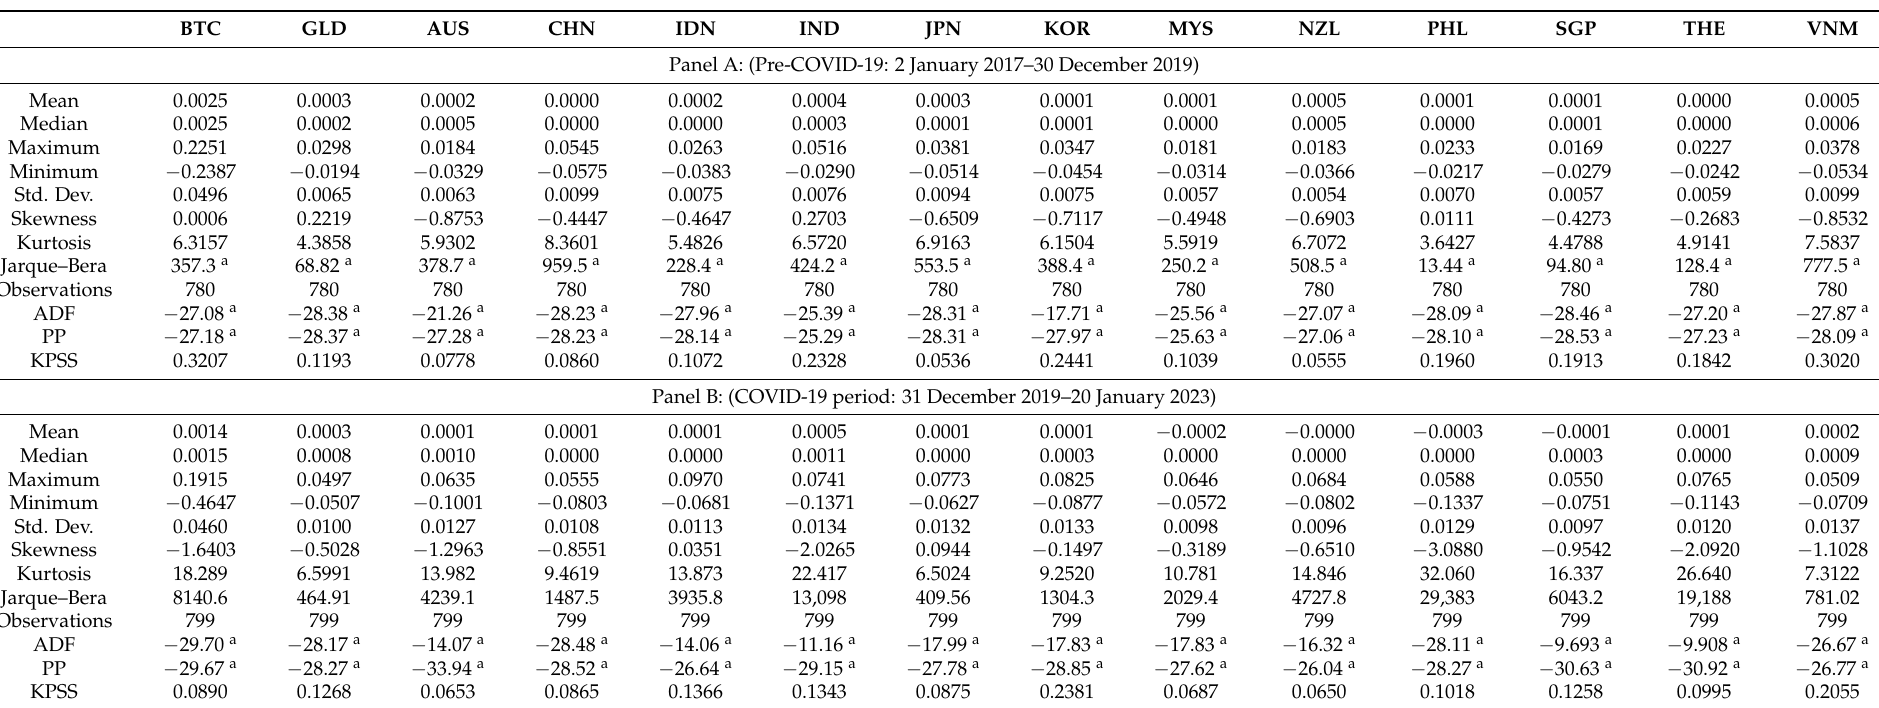
Table 1. Descriptive statistics of daily